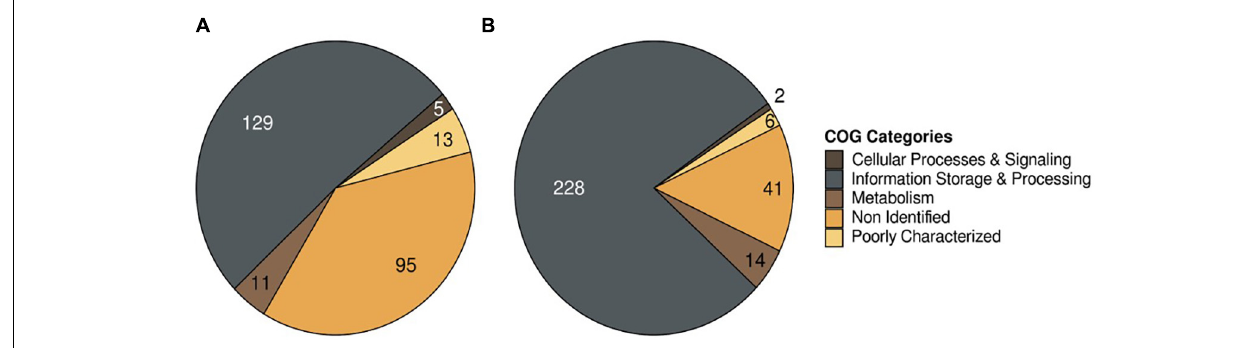
FIGURE 2 | COG annotation of unique genes in P. salmonis genogroups. (A) LF-89 genogroup; (B) EM-90 genogroup.